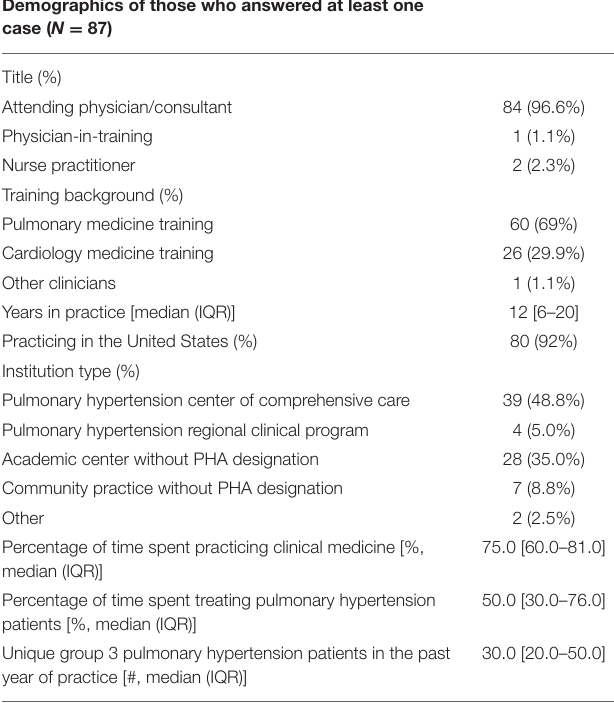
TABLE 1 | Demographic characteristics of the survey respondents. Demographics of those who answered at least one case ( N =